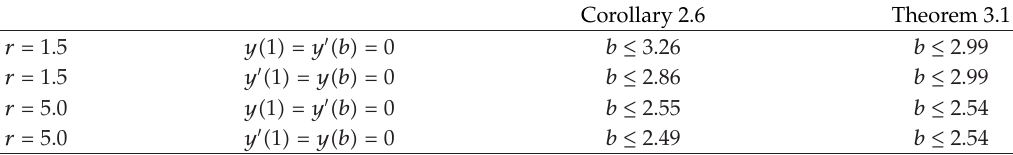
Table 1: Comparison of upper bounds for b in Example 4.1.